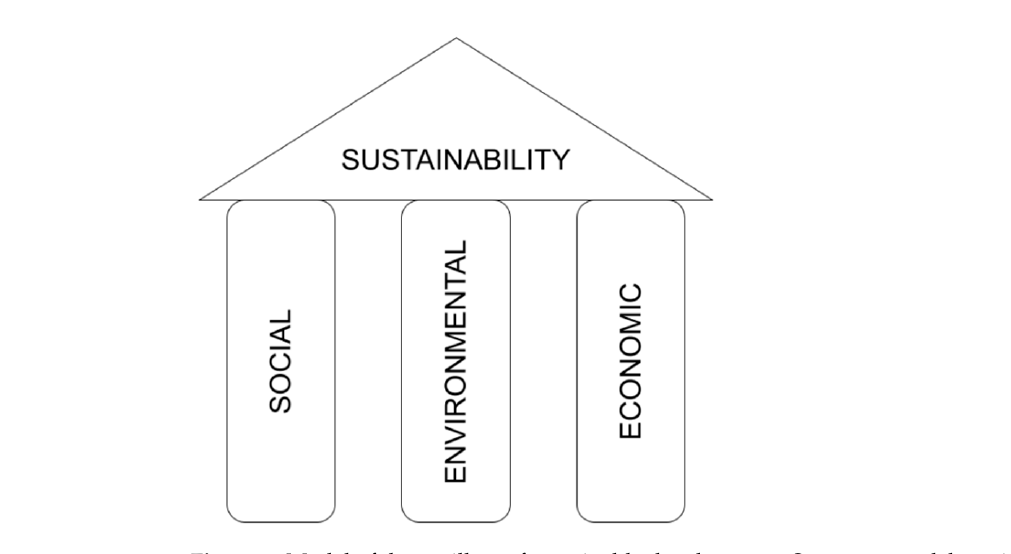
Figure 1. Model of three pillars of sustainable development. Source: own elaboration based on [3].